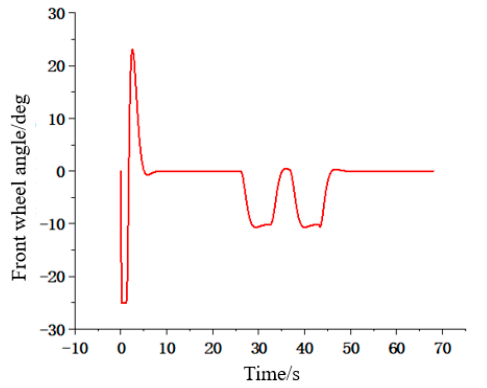
Figure 16. Front-wheel rotation angle change diagram.